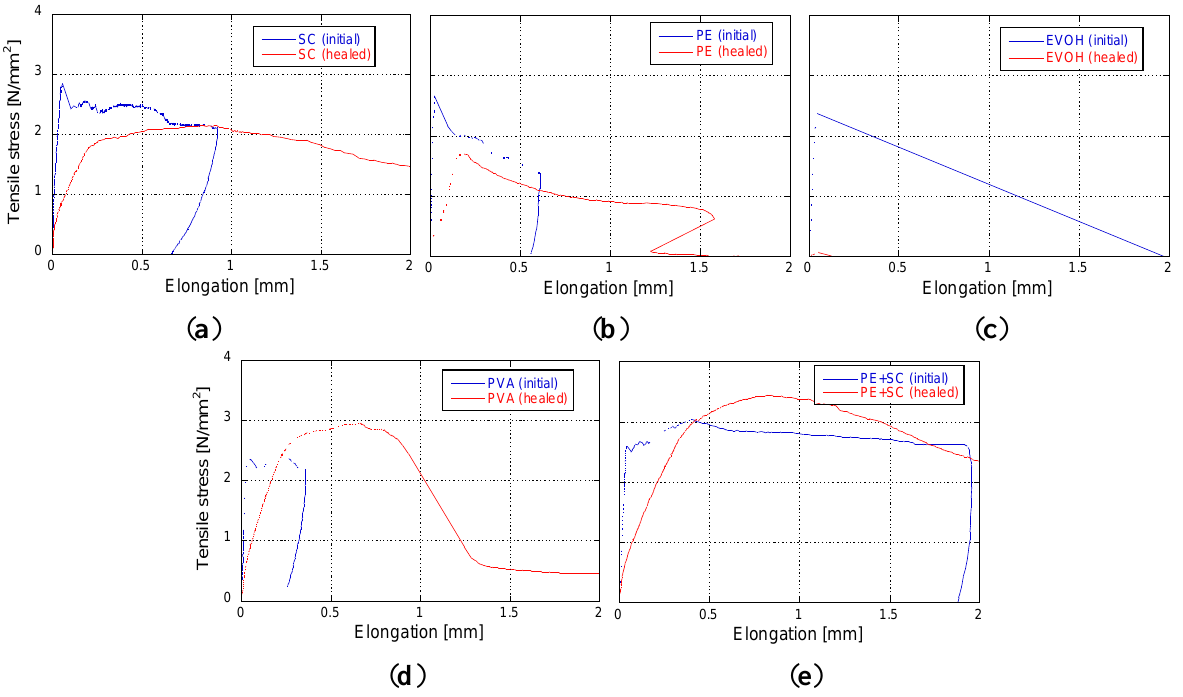
Figure 10. Schematic diagram of relationship between tensile stress and